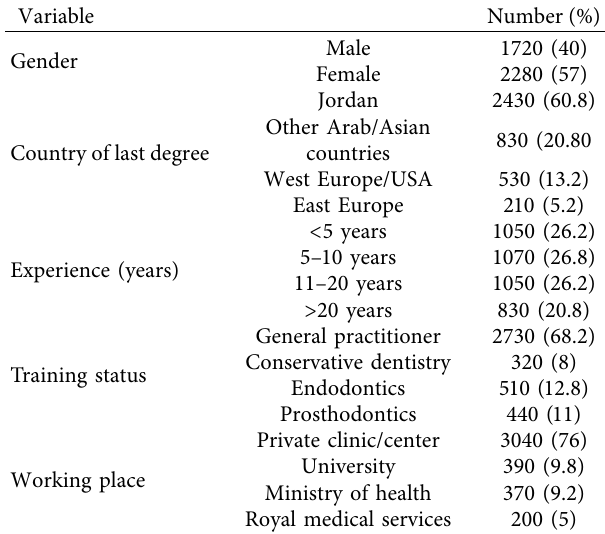
Table 1: Sociodemographic characteristics of the studied